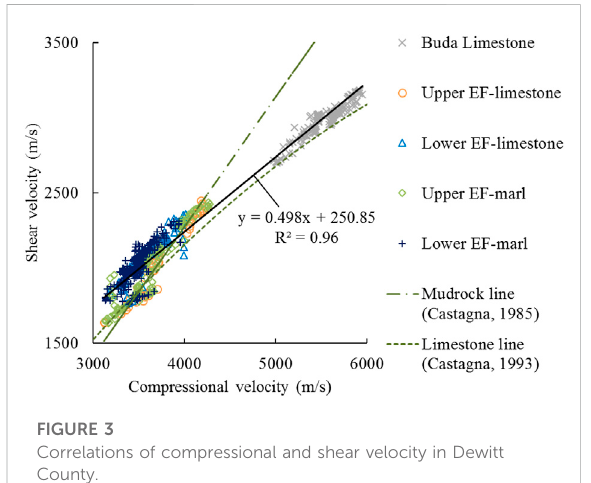
FIGURE 4 Correlations of compressional velocity and gamma ray in different layers.